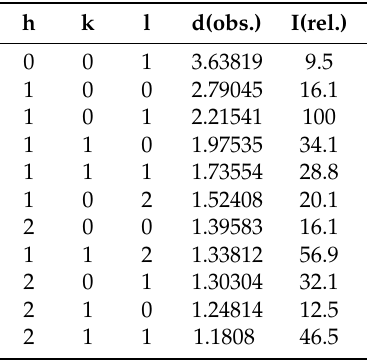
Table 2. X-ray diffraction pattern of platiniferous tetra-auricupride from Bolshoy Khailyk. h k l